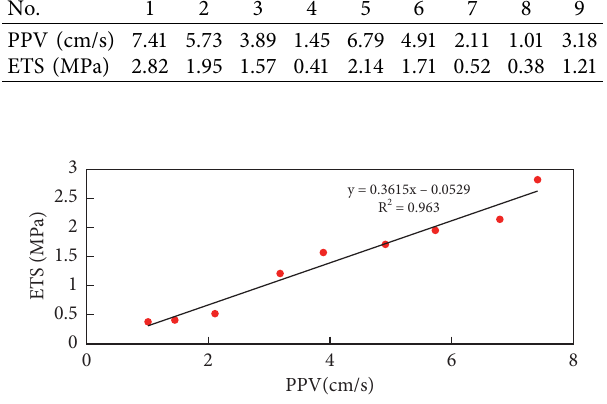
Figure 9: Relationship between PPV and